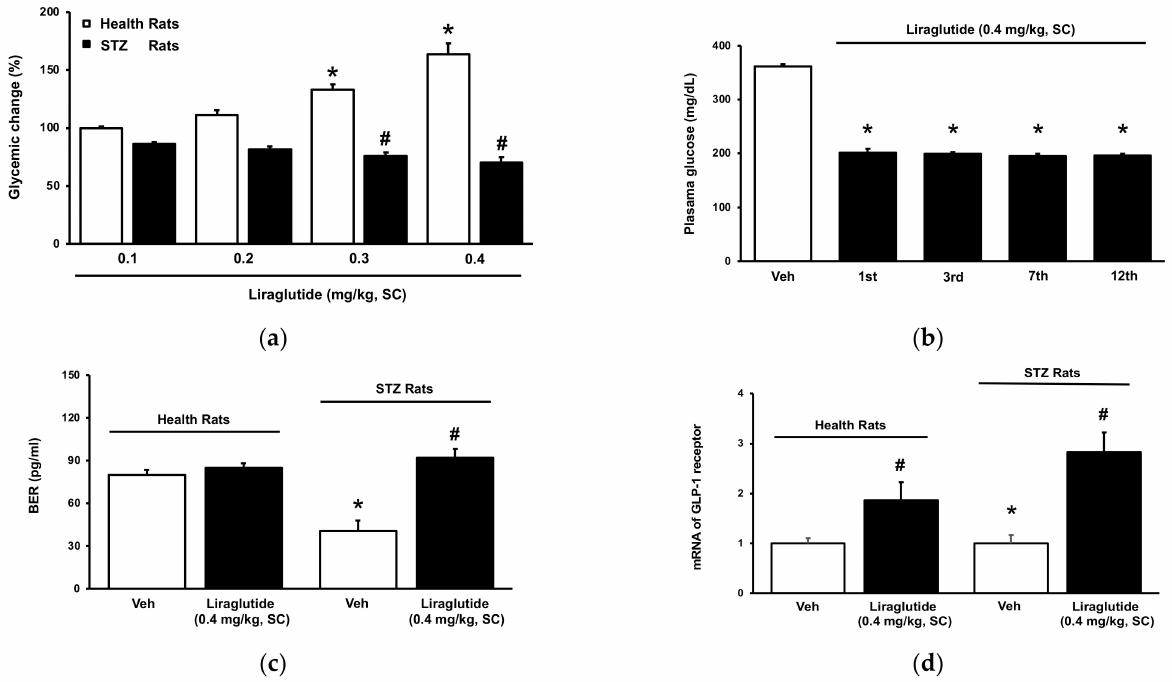
Figure 4. Influence of liraglutide in type-1 diabetic rats. ( a ) Dose-dependent effects of liraglutide on plasma glucose in diabetic rats were different with that in normal rats. Glycemic change was calculated by the percentage change in resulted plasma glucose prior; ( b ) Tolerance to liraglutide- induced hypoglycemia was not observed in diabetic rats and hypoglycemic response to liraglutide produced in diabetic rats receiving daily injection; ( c ) Effects of liraglutide on adrenal gland isolated from diabetic rats were different with that from normal rats. Beta-endorphin released by liraglutide as the functions of GLP-1R activation was observed in adrenal glands isolated from diabetic rats only; ( d ) The mRNA level of GLP-1R in adrenal glands between normal and diabetic rats. GLP-1R expression promoted by liraglutide in adrenal glands was higher in diabetic rats than normal rats. Thus, liraglutide promotes the mRNA level of GLP-1R in adrenal glands isolated from diabetic rats only. The data are shown as means ± SEM ( n = 8). * p < 0.05 vs. low dose of liraglutide ( a ), vs.